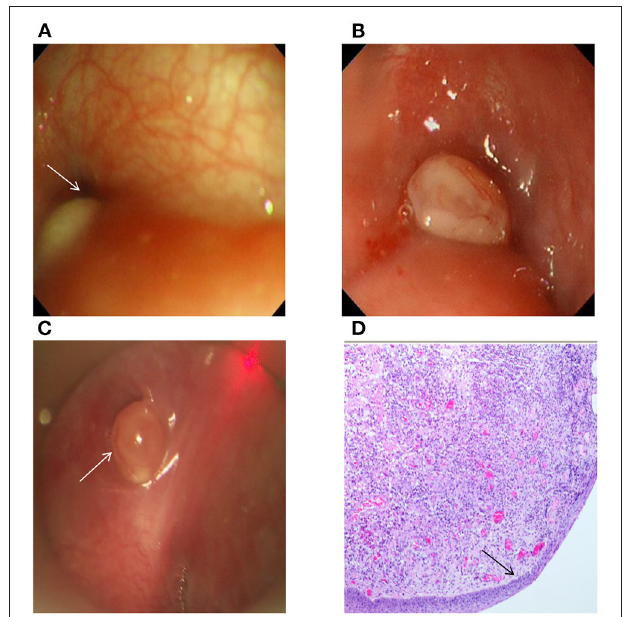
FIGURE 2 | (A) The right pyriform sinus under the gastroscope had an oval mass with a size of 0.5cm × 0.2cm, the surface was smooth, and the internal fistula opening in the left pyriform sinus could be observed. (B) The left pyriform sinus under the gastroscope had an oval mass with a size of ∼ 0.3cm × 0.4cm, the surface was smooth and covered by a small amount of mucus, and there was no clear fistula opening. (C) Granulation in the left pyriform sinus was observed in the patient in panel (B) by support laryngoscopy, and there was a deep internal fistula opening with a size of ∼ 5mm. (D) The postoperative pathology of the patient in panel (B) showed that the surface was covered by squamous epithelia, and that there was inflammatory granulation tissue under the epithelia (H&E, × 40). The arrow indicates the internal opening of CPSF (A,C) and squamous epithelia (D)